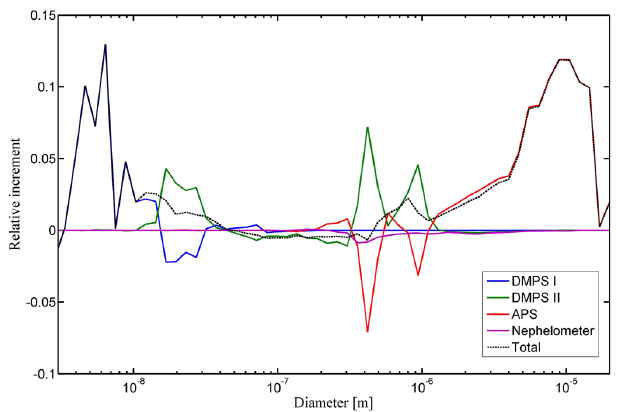
Fig. 7. The average relative increment for DMPS I (blue), DMPS II (green), APS (red), nephelometer (purple) as well as the average total relative increment (black, dashed) on 7 May